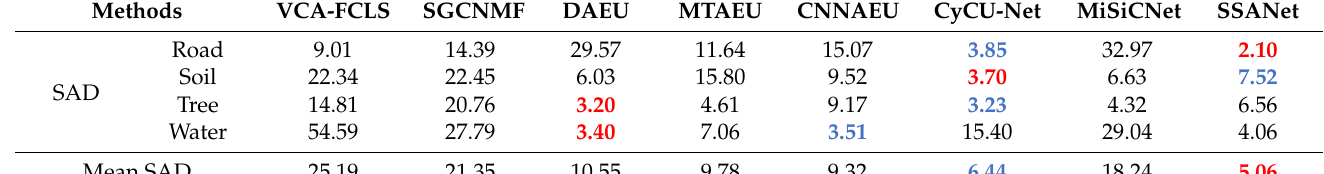
Table 5. SAD ( × 100) and mean SAD ( × 100) of endmembers acquired by various unmixing ap- proaches on Jasper Ridge data. Annotation: bold red text indicates the best results and bold blue text indicates the suboptimal results.